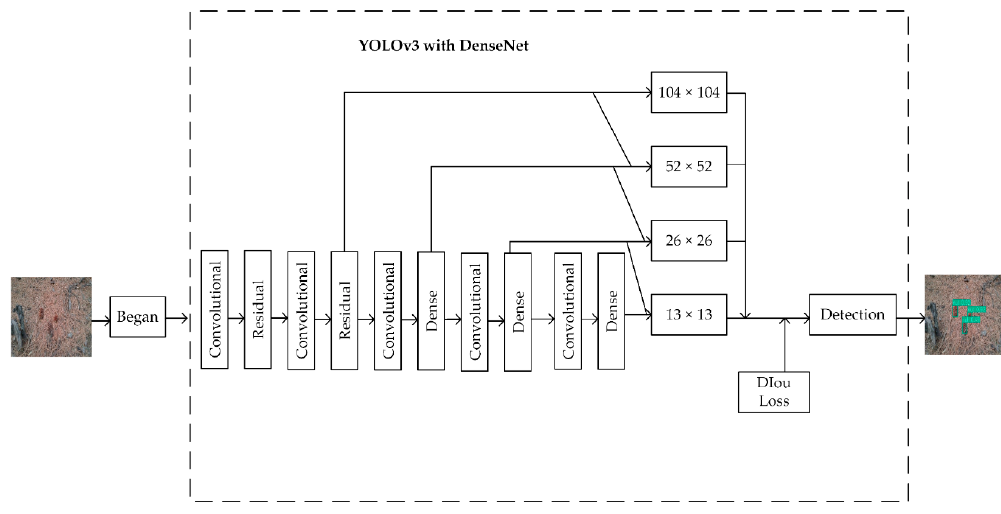
Figure 9. Experimental scheme.